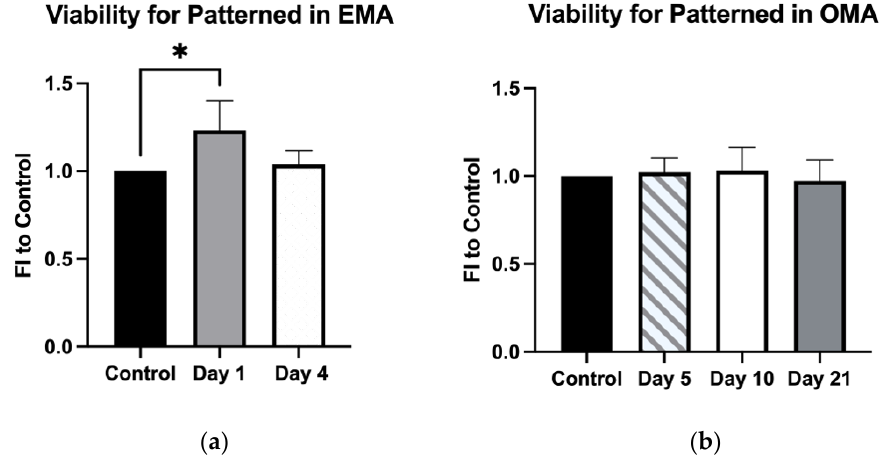
Figure 3. Cell viability of mMSCs measured by Presto Blue assay in patterned and non-patterned gels, cultured either in expansion degradation-free media with protinin (EMA) ( a ) or osteogenic degradation-free media with aprotinin (OMA) ( b ). * represents p ≤ 0.05. FI stands for fold induction compared to control (non-patterned gels).